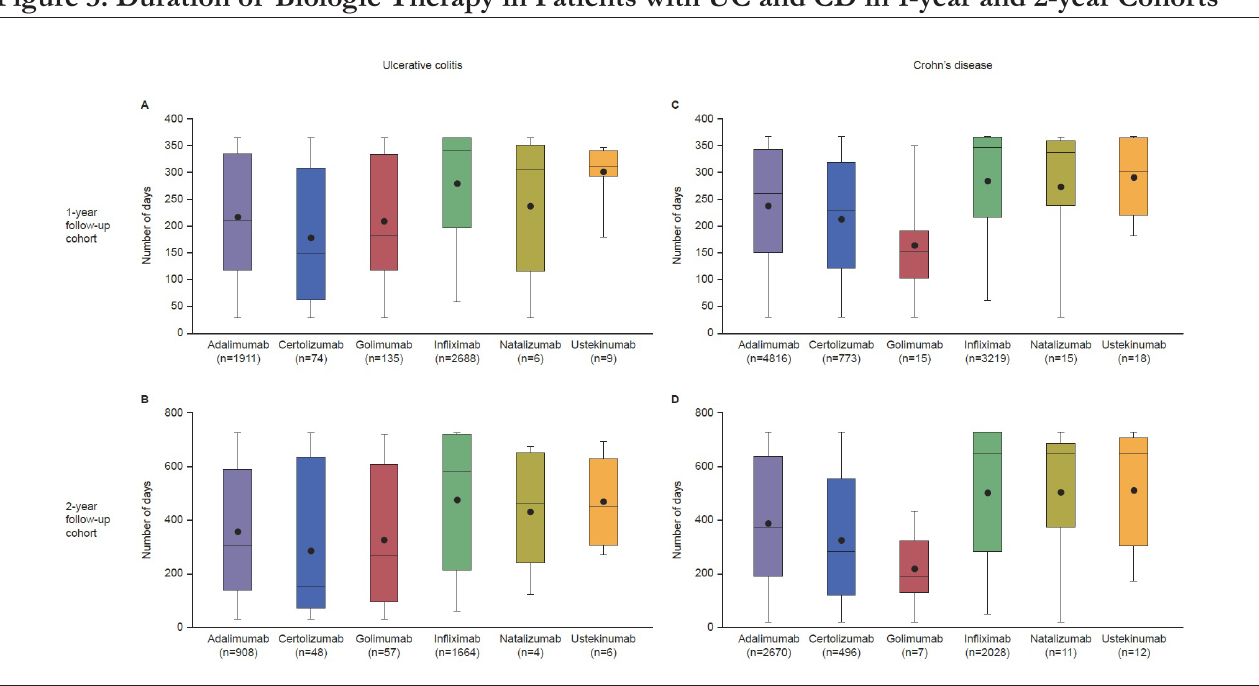
Median duration (with interquartile range) of biologic therapy in patients with UC (A and B) and CD (C and D) in the 1-year (A, C) and 2-year follow-up (B, D) cohorts (ITT population). Mean value represented by black circle. Note: natalizumab and ustekinumab are not currently approved for treating UC and are likely captured due to off-label prescription and/or the algorithm used to categorize patients with UC versus CD. CD: Crohn’s disease; ITT: intention-to-treat; UC: ulcerative